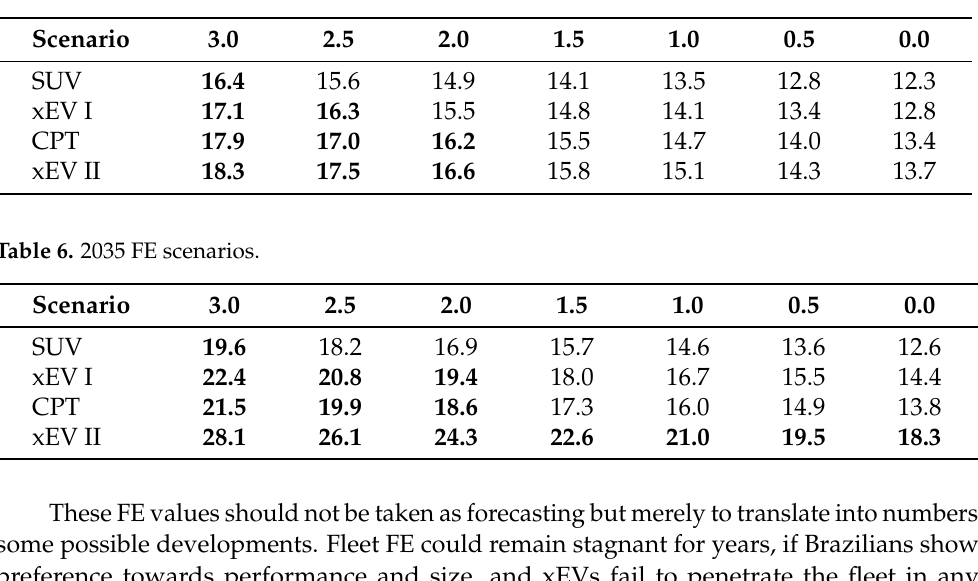
Table 5. 2030 FE scenarios.